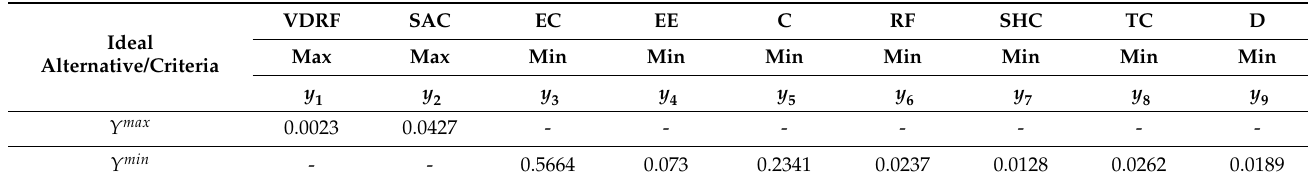
Table 10 presents the decomposition of the ideal alternatives. Table 10. Decomposition of the ideal alternatives.